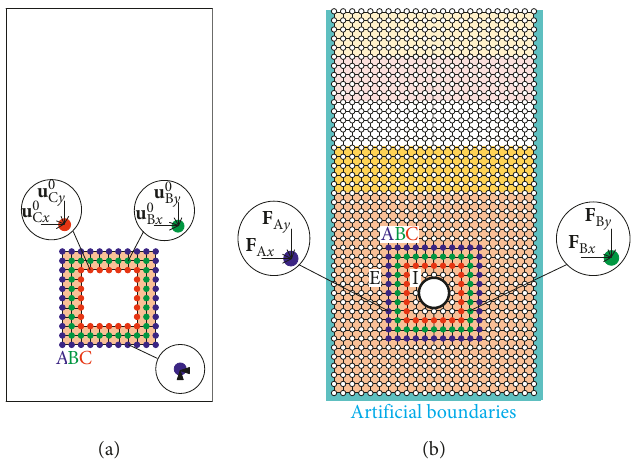
Figure 2: Implementation procedures of the modified internal substructure method: (a) nodal load calculation in the internal substructure; (b) seismic wave input in the soil-structure